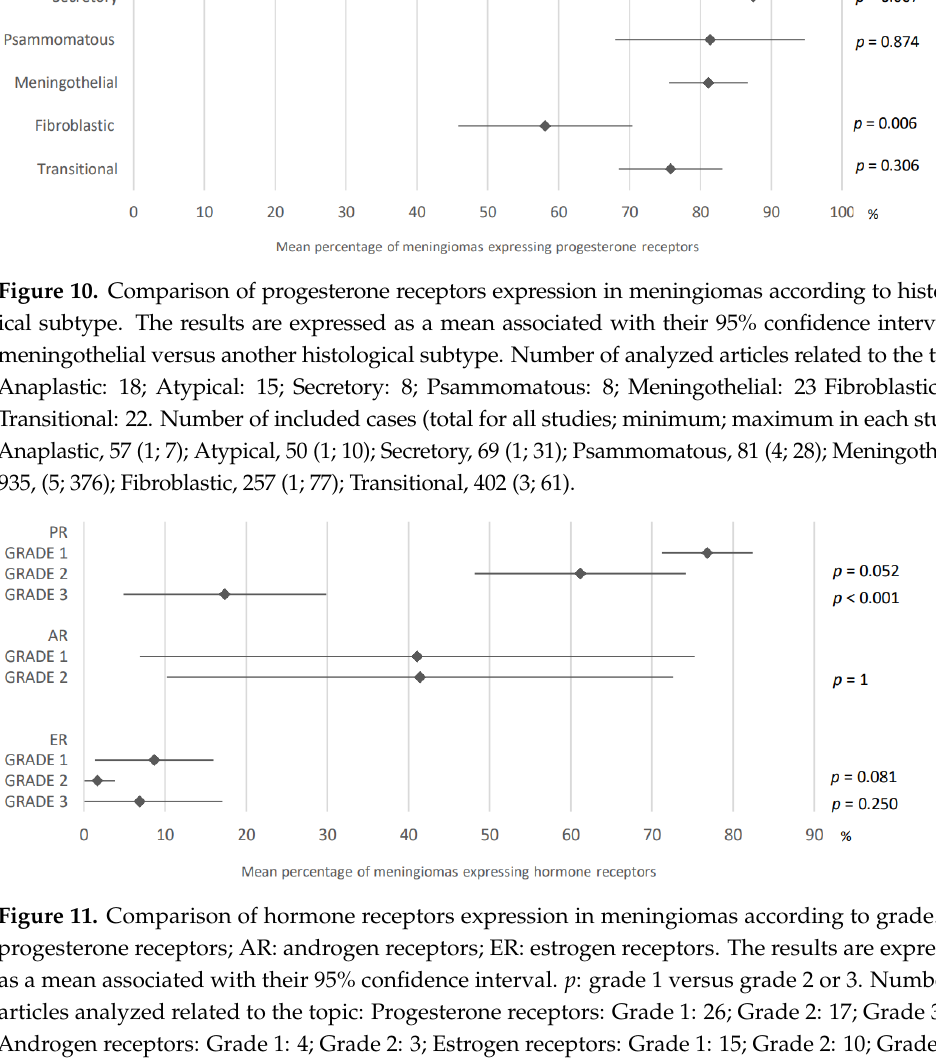
9 of 18 Figure 9. Comparison of hormone receptors expression in meningiomas according to their location. PR: progesterone receptors; AR: androgen receptors; ER: estrogen receptors. The results are ex- pressed as a mean associated with their 95% confidence interval. p *: intracranial versus spine; p **: skull base versus non skull base. Number of articles analyzed related to the topic: Progesterone receptors: Intracranial: 36; Spine: 7; Skull base: 10; Non-skull base: 8; Androgen receptors: Intracra- nial: 5; Estrogen receptors: Intracranial: 24; Spine: 2; Number of included cases (total for all studies; minimum; maximum in each study): Progesterone receptors: Intracranial, 2685 (11; 588); Spine, 119 (1; 58); Skull base, 383 (4; 208); Non-skull base, 244 (7; 100); Androgen receptors: Intracranial, 246 (30; 96); Estrogen receptors: Intracranial, 1285 (11; 161); Spine, 34 (4; 30). Regarding estrogen receptors, 11.9% of intracranial meningiomas expressed the latter versus 15% of spinal ones (95% CI: 6.1 – 17.7 and 95% CI: 0 – 44.4). These data were obtained after analysis of 24 and two articles (Figure 9), respectively. 3.4.2. Histological Subtype 81.1% of meningothelial meningiomas expressed progesterone receptors (95% CI: